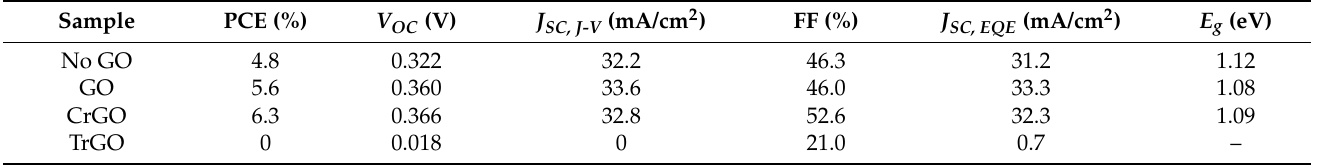
Figure 7. Statistical box charts of ( a ) the power conversion efficiency (PCE), ( b ) open-circuit voltage ( V OC ), ( c ) short-circuit current density ( J SC ), and ( d ) fill factor (FF) of the CZTSSe solar cells fabricated with the various graphene oxide intermediate layers ( n = 6). Table 2. Solar cell parameters obtained from J-V curves and external quantum efficiency data of the CZTSSe solar cells with different intermediate layers 1